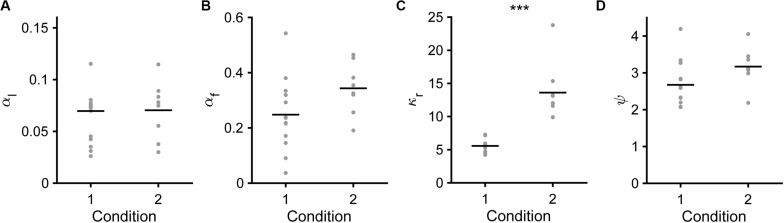
Model parameters in the saving-F model. (A) Learning rate (αl). Mean ± standard deviation, 0.069 ± 0.037 in condition 1, 0.070 ± 0.028 in condition 2, p = 0.587. (B) Forgetting rate (αf). 0.247 ± 0.131 in condition 1, 0.343 ± 0.092 in condition 2, p = 0.0550. (C) Subjective goodness of water reward (κr). 5.567 ± 1.101 in condition 1, 13.604 ± 4.469 in condition 2, ***p = 1.92 × 10–4. (D) Subjective goodness of covert reward (ψ). 2.673 ± 0.626 in condition 1, 3.170 ± 0.521 in condition 2, p = 0.0550.